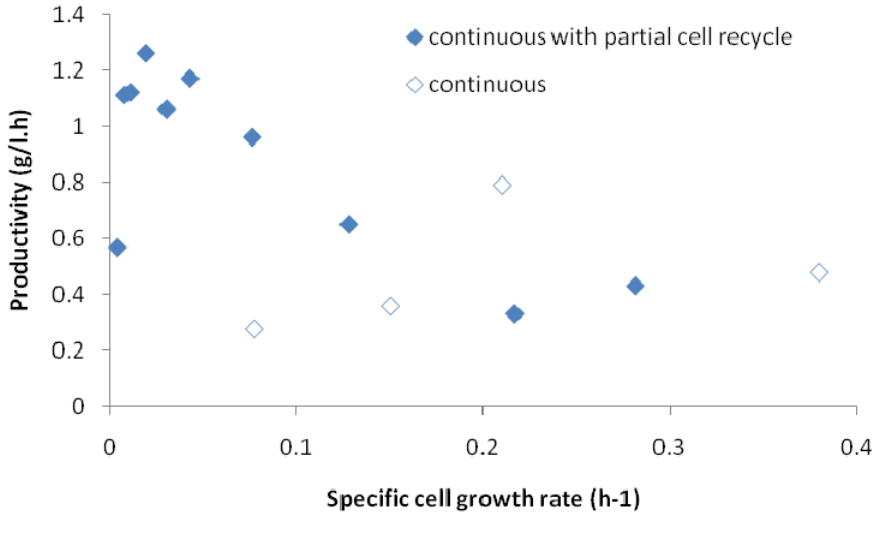
Figure 4. Influence of specific cell growth rate to productivity of butyric acid in continuous fermentation by C. tyrobutyricum at pH of